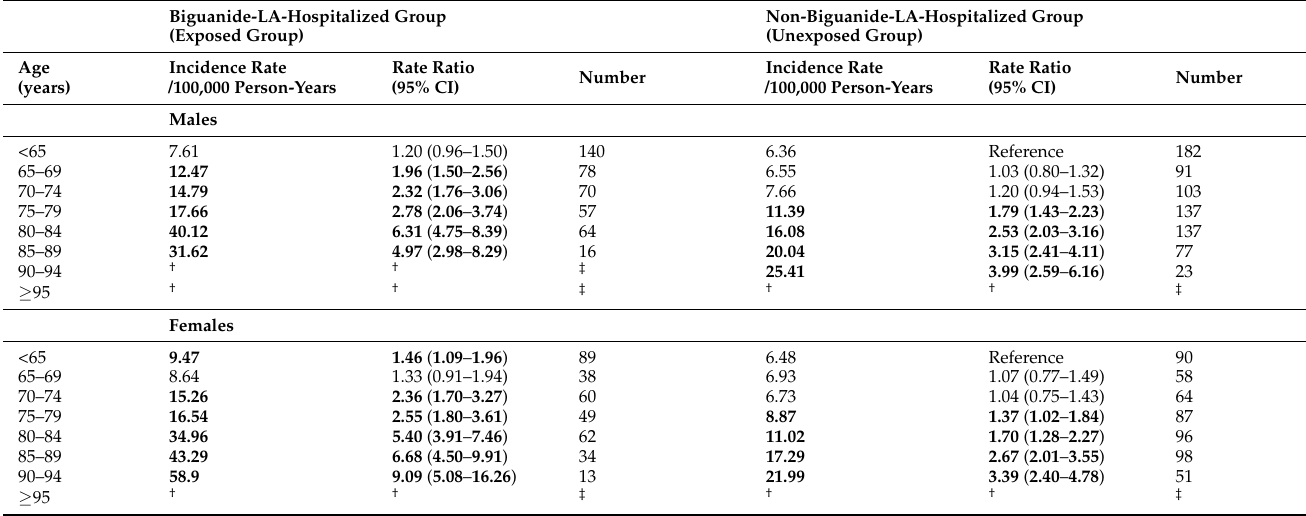
Table 3. Incidence Rate of Lactic Acidosis by Age among Hospitalized DM Patients in Japan.